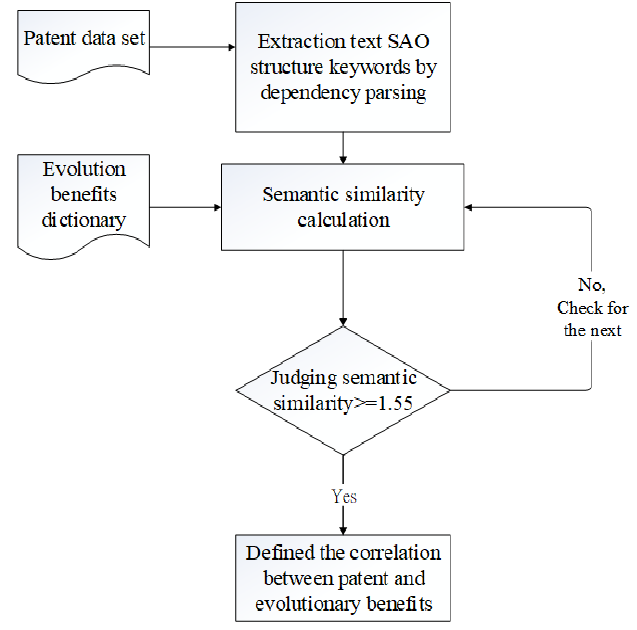
Figure 7. Flowchart of evolution benefits and patent text analysis.